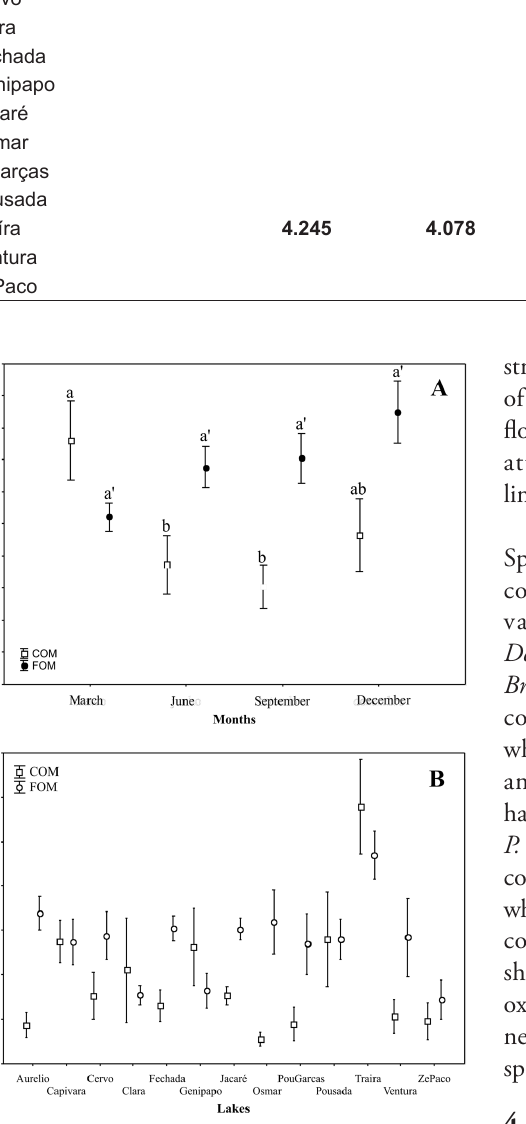
Figure 3. Mean and standard deviation of the organic matter percentage in each months (A) and lake (B) analyzed. COM: Coarse Organic Matter; FOM: Fine Organic Matter.